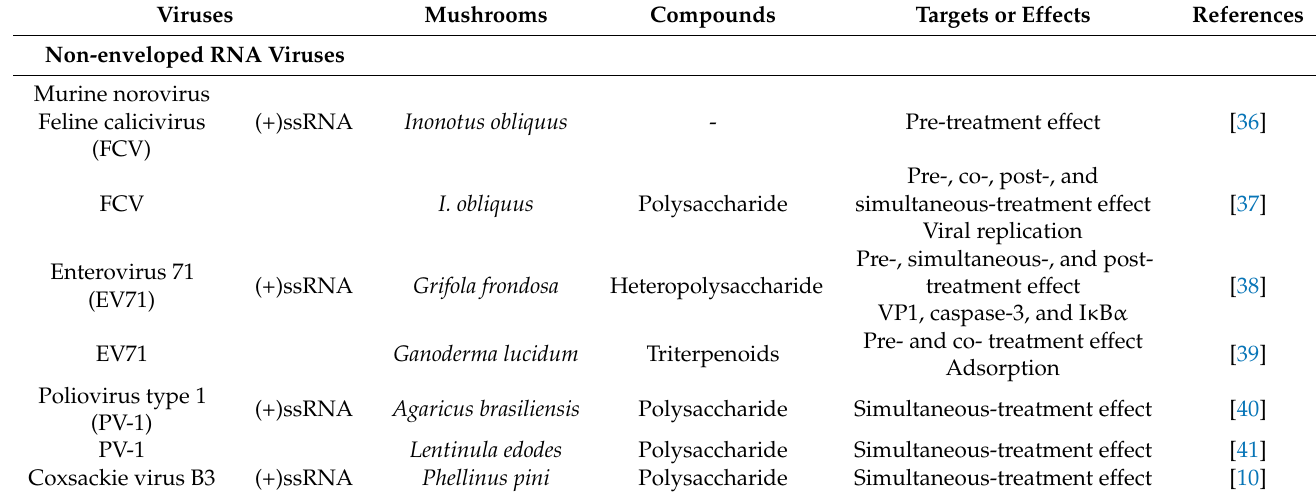
Table 3. Mushroom compounds and their antiviral targets against non-enveloped RNA viruses.